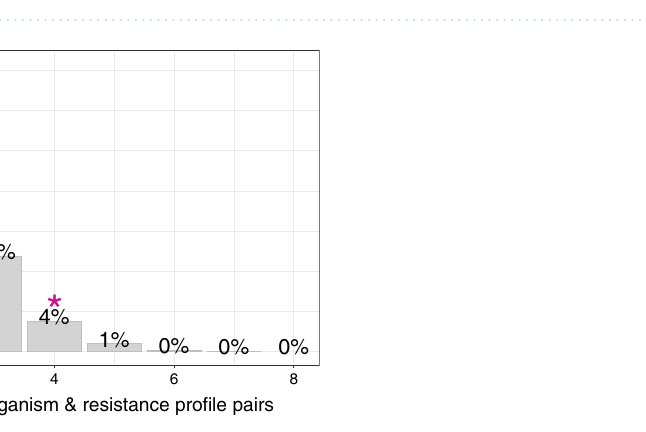
Figure 3. A comparison of resistance profiles of 3GC-R Gram-negative organisms isolated from blood and rectal swabs. ( A ) Twelve neonates had the same organism in their blood and rectum. Dark green indicates a match in resistance/susceptibility between the two isolates, light green represents a mismatch. Four pairs had identical resistance profiles (bold). ( B ) Breakdown of antibiotic susceptibility profiles of the four organisms with identical resistance patterns isolated from blood and rectum. SXT trimethoprim–sulfamethoxazole, S susceptible, R resistant.